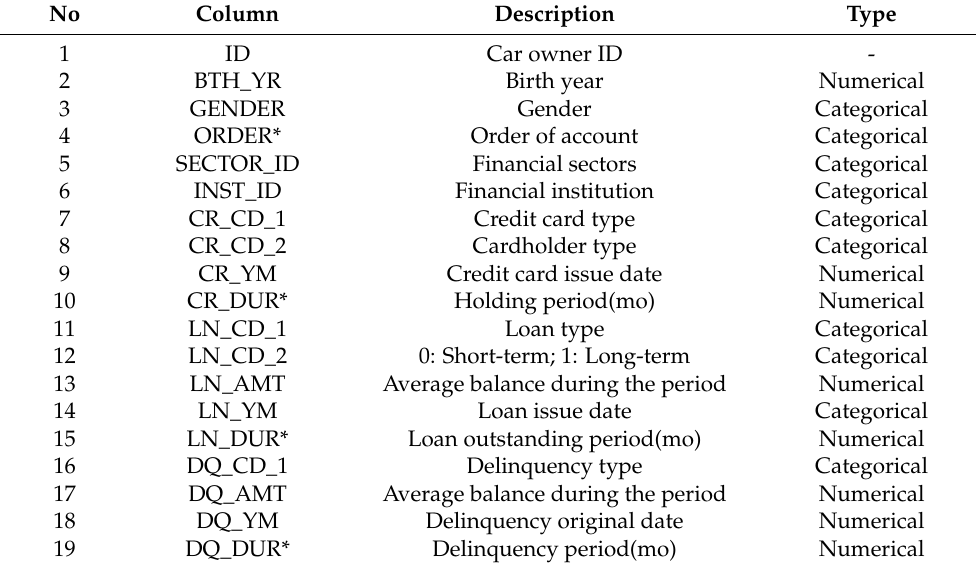
Table 2. Line-History Table.